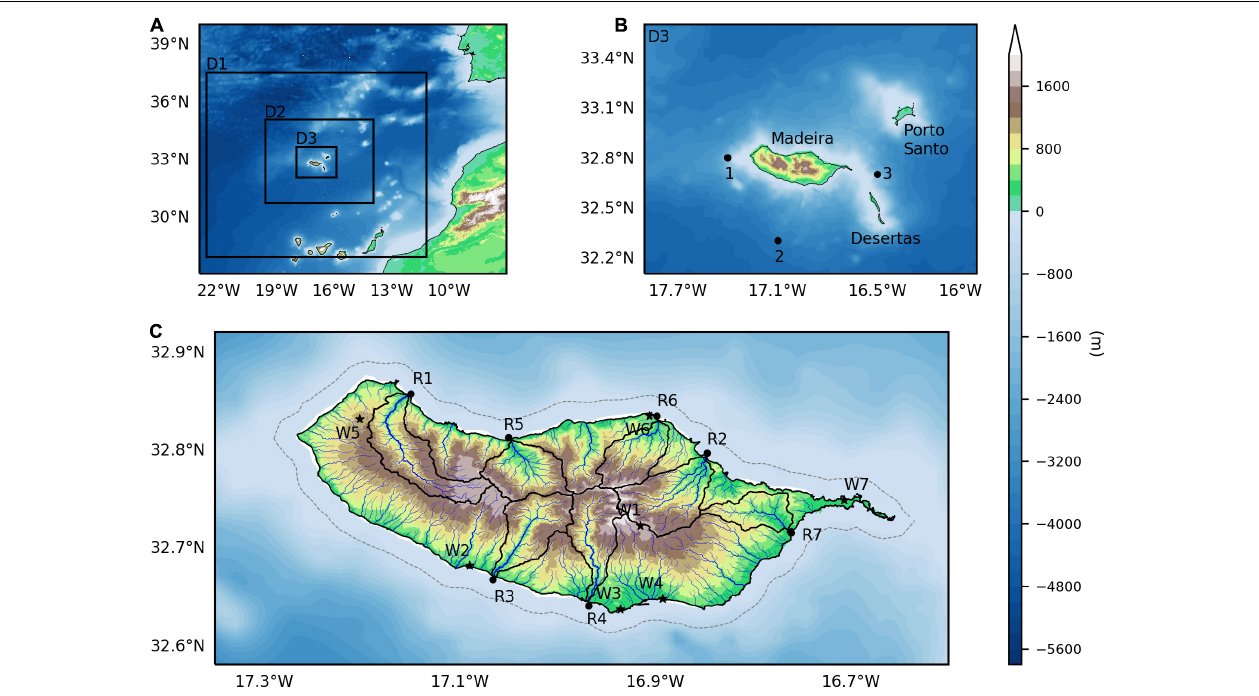
FIGURE 3 | Map of the study area showing the topography and bathymetry retrieved from the Shuttle Radar Topography Mission (SRTM). (A) Representation of the three nested COAWST model domains (black boxes D1, D2, and D3, corresponding to 9, 3, and 1 km resolution, respectively). (B) Model domain D3 encompassing the regional area of Madeira Archipelago (Selvagens are not shown), where numbers correspond to locations used for model validation. (C) Madeira Island showing: (i) the drainage network (blue lines), with identification of the main river outlets (R1—Ribeira da Janela, R2—Ribeira de São Roque do Faial, R3—Ribeira Brava, R4—Ribeira dos Socorridos, R5—Ribeira de São Vicente, R6—Ribeira de São Jorge, R7—Ribeira de Machico; black circles) and its drainage basins (delimited by black lines); (ii) the location of the meteorological stations deployed by IPMA (Portuguese Institute for Sea and Atmosphere; black stars W1–W7) used for model validation; (iii) the location where vertical transects parallel to the north and south coast were performed (gray dashed lines). TABLE 1 | Geometric characteristics (orientation, area, maximum altitude, main river length, total network length, drainage density and mean drainage slope) of the main rivers of Madeira Island. River Orientation Area Maximum Main river Total network Drainage density Mean drainage (km 2 ) altitude (m) length (km) length (km) (km − 1 ) slope ( ◦